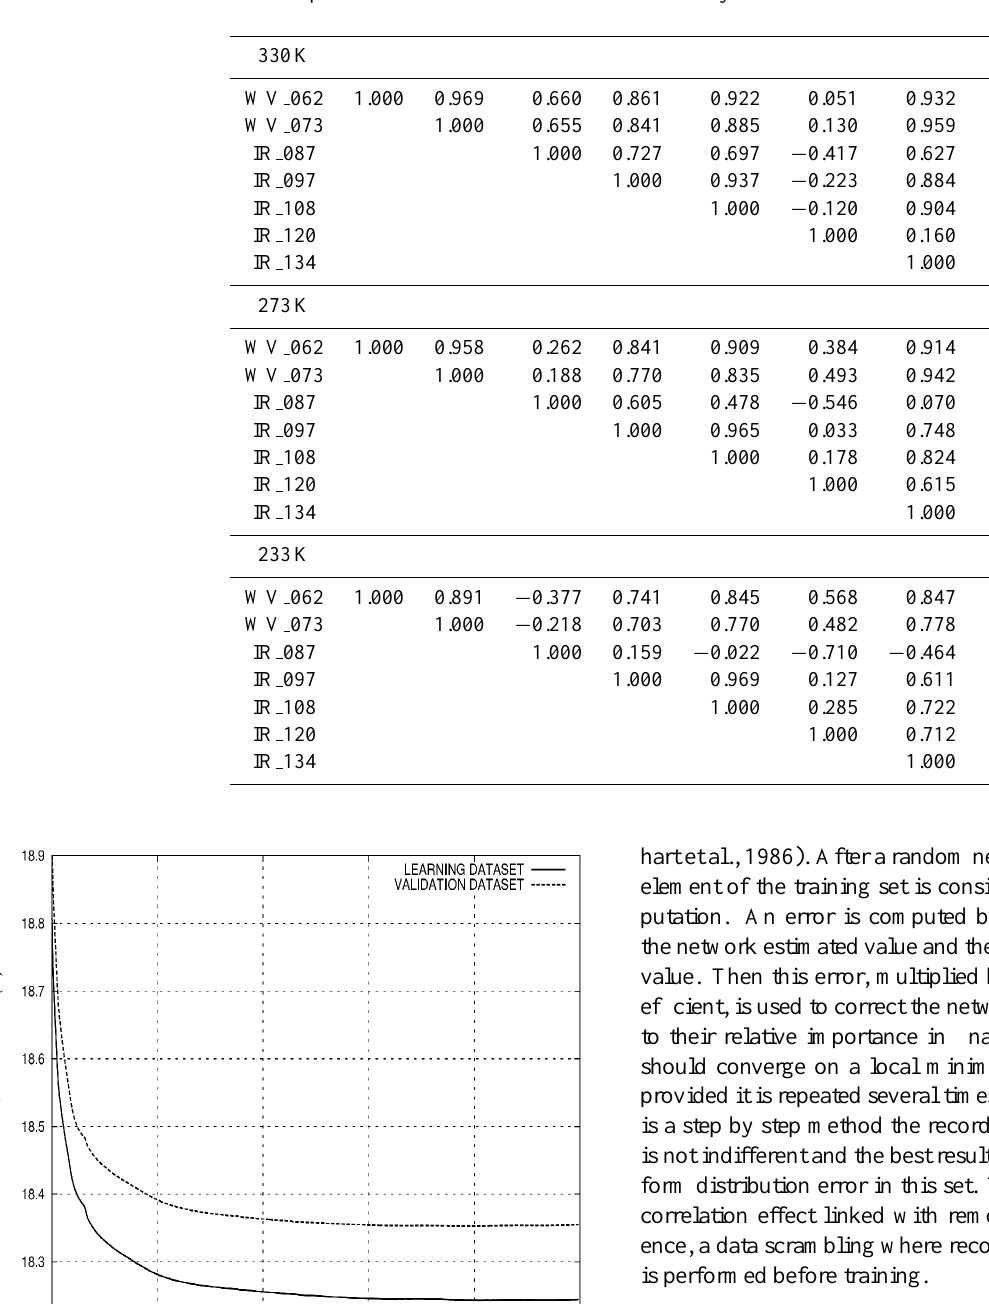
Table 2b. Correlation matrices computed with three different thresholds. Same layout as in Table 2a.